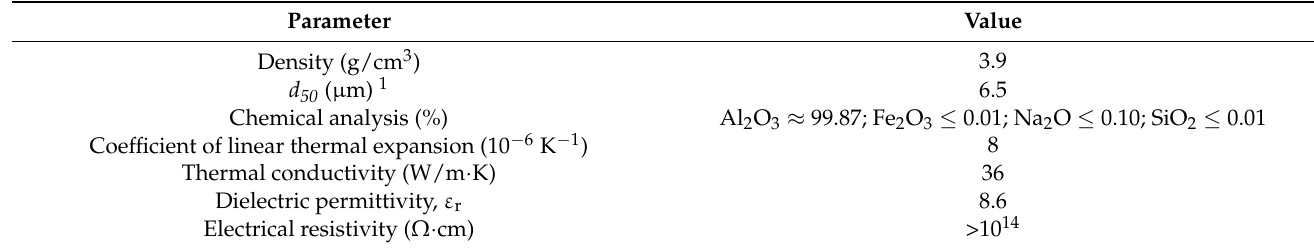
Table 2. Basic parameters of the reference alumina